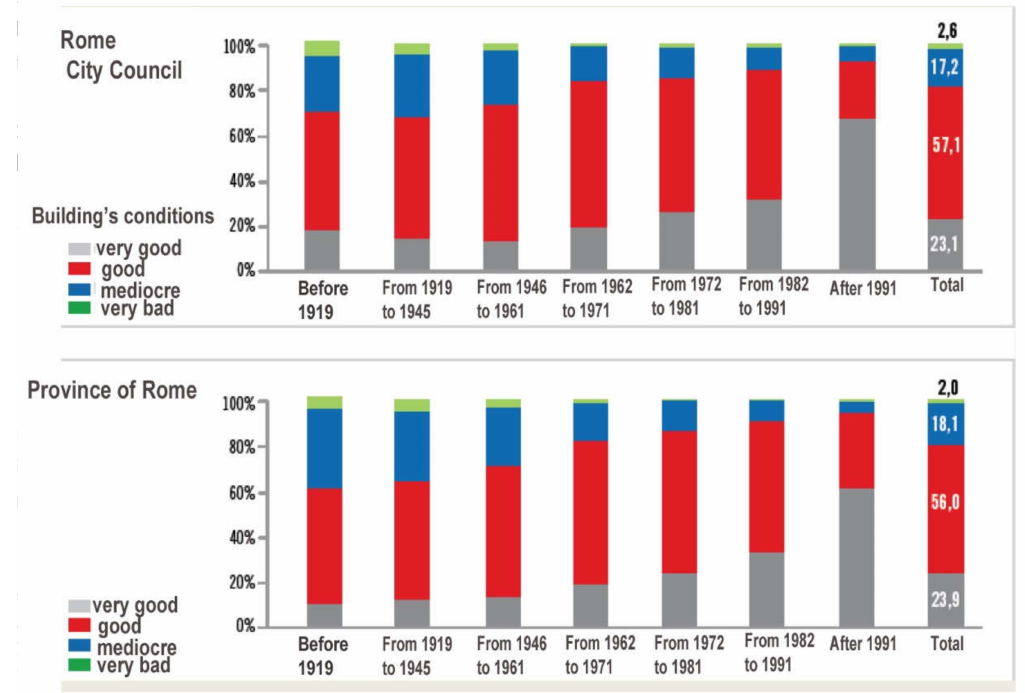
Figure 1. Ages of construction of the buildings in the city of Rome and its province, Italy. Source: